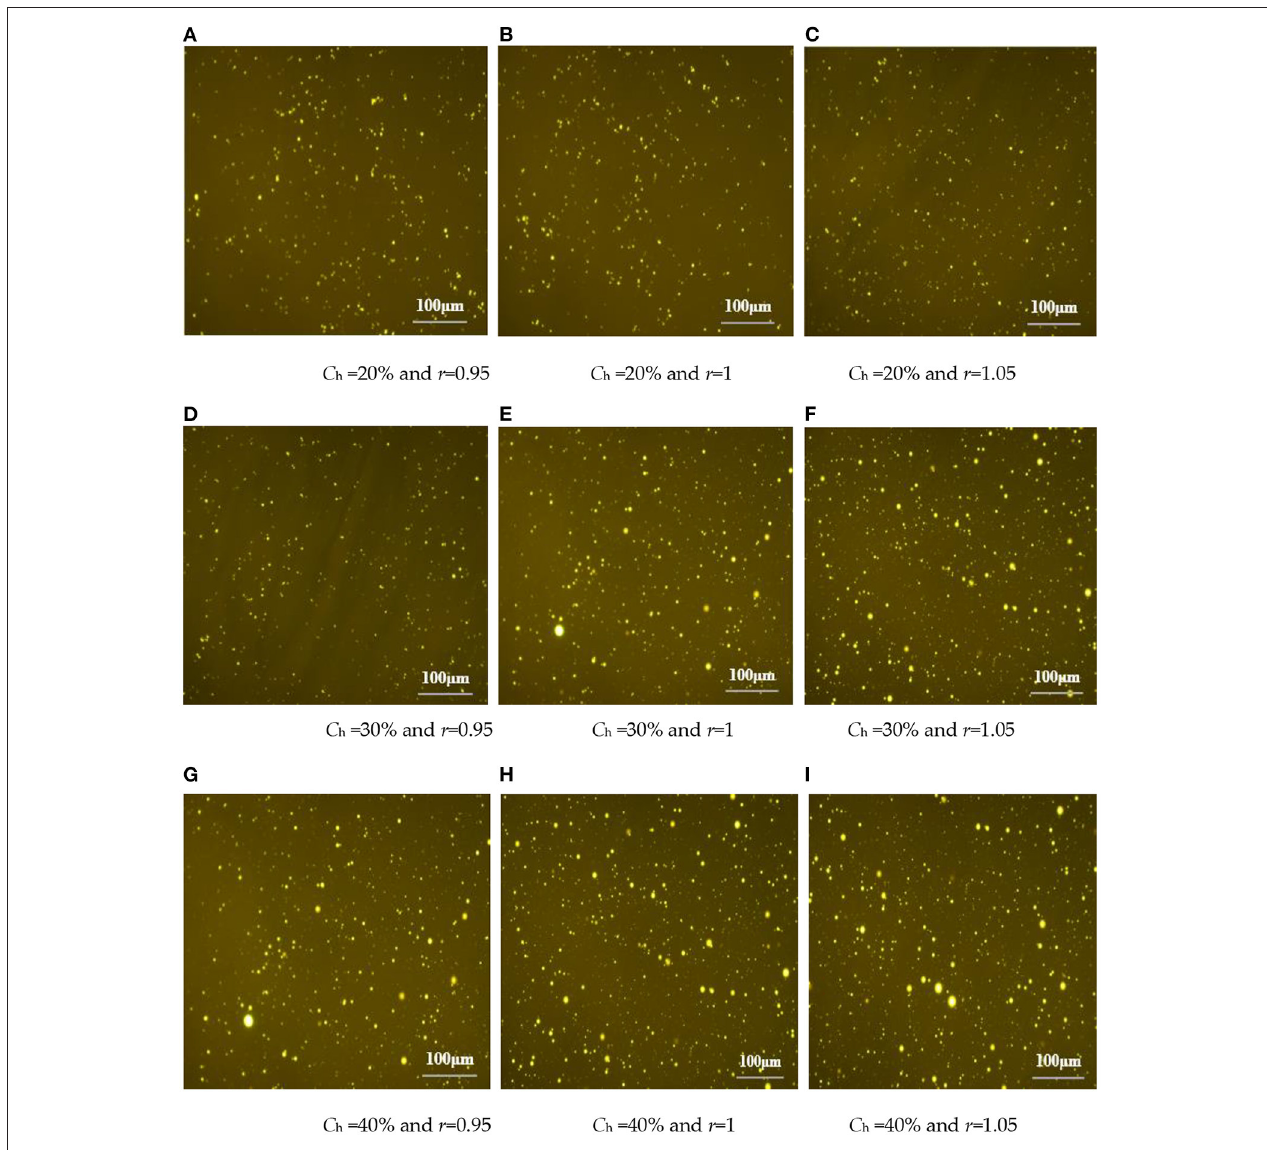
FIGURE 21 | Fluorescence micrographs of polyether-based TPU-modified asphalt. (A) C h = 20% and r = 0.95. (B) C h = 20% and r = 1. (C) C h = 20% and r = 1.05. (D) C h = 30% and r = 0.95. (E) C h = 30% and r = 1. (F) C h = 30% and r = 1.05. (G) C h = 40% and r = 0.95. (H) C h = 40% and r = 1. (I) C h = 40% and r =